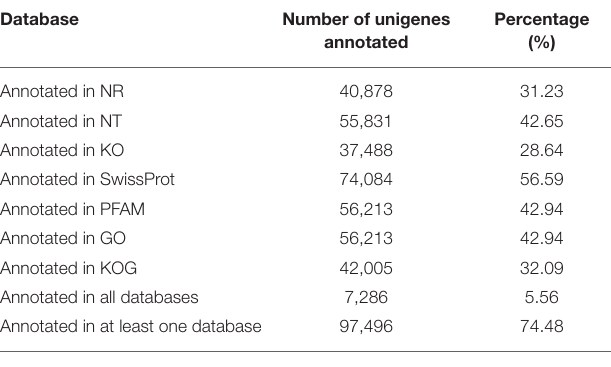
TABLE 2 | Summary of functional annotation of assembled unigenes in C. rhombifolium .